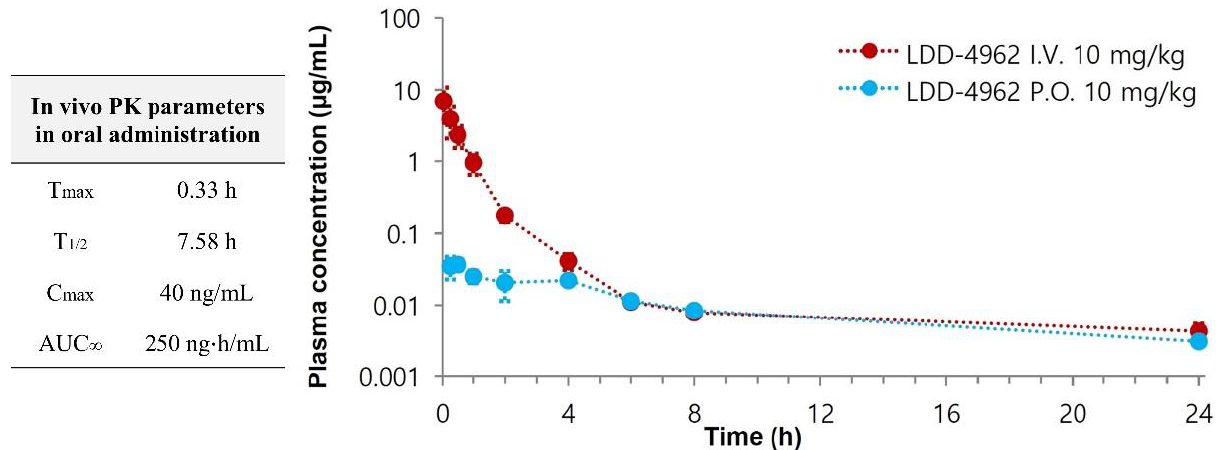
Figure 4. In vivo pharmacokinetic study of compound 14h .